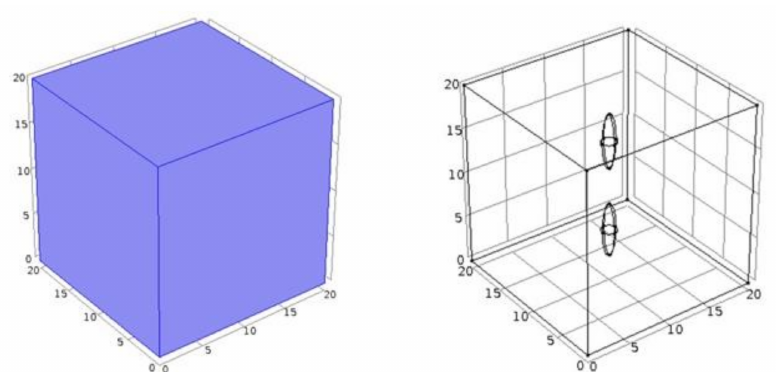
Figure 5. A cubic cell of 20 × 20 × 20 µ m with two water voids.